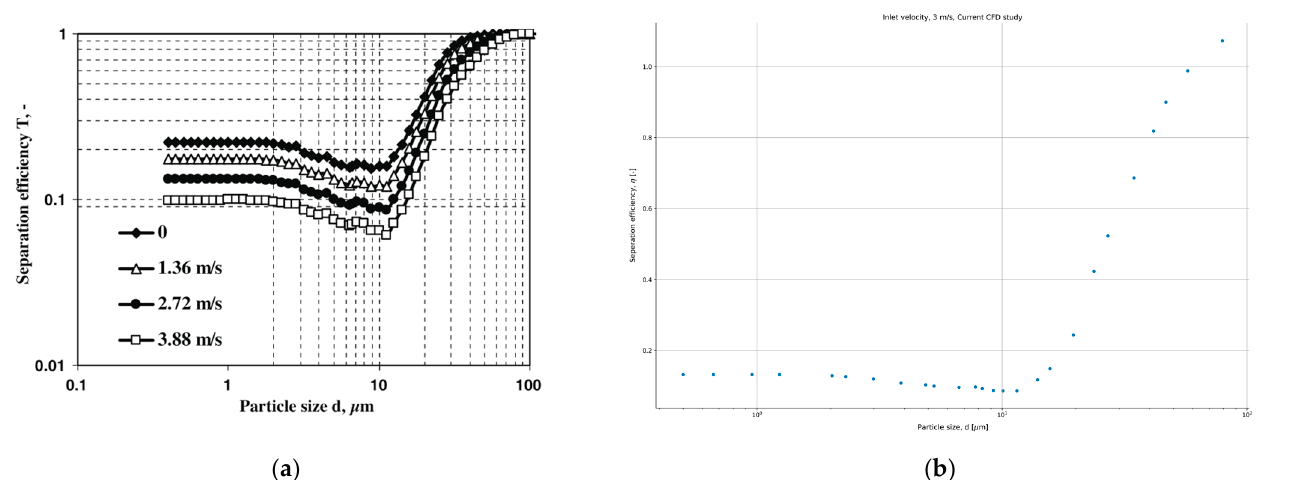
Figure 3. Model validation against ( a ) Simulated partition curves of a 50-mm hydrocyclone curves for different injection velocities [35], Reproduced with permission from Dueck et al., Mechanism of hydrocyclone separation with water injection; published by Elsevier, 2010. ( b ) Current CFD for a 3 m/s inlet